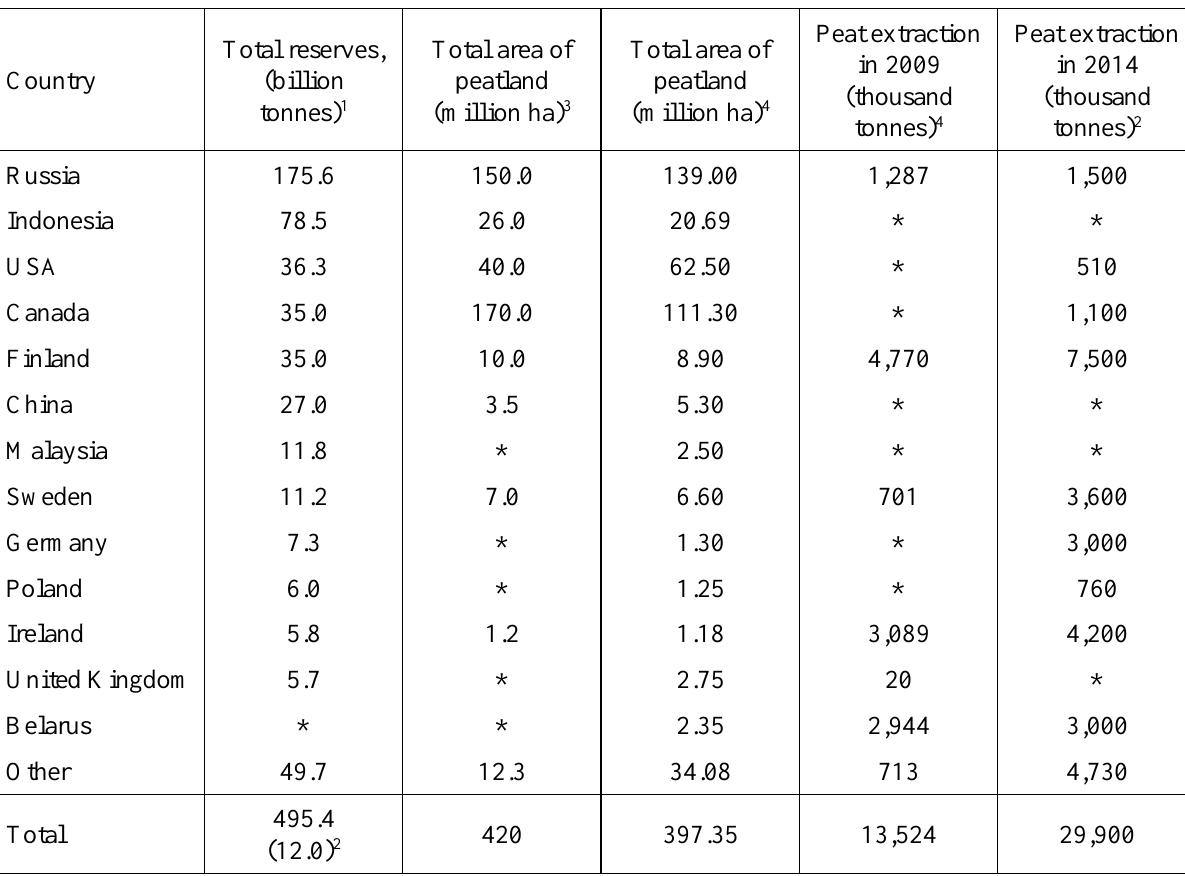
Table 2. The global distribution of peat reserves by country. Sources: 1 Institute of the Peat Industry 2015, 2 USGS 2016, 3 Peat Resources Limited 2015, 4 WEC 2013.